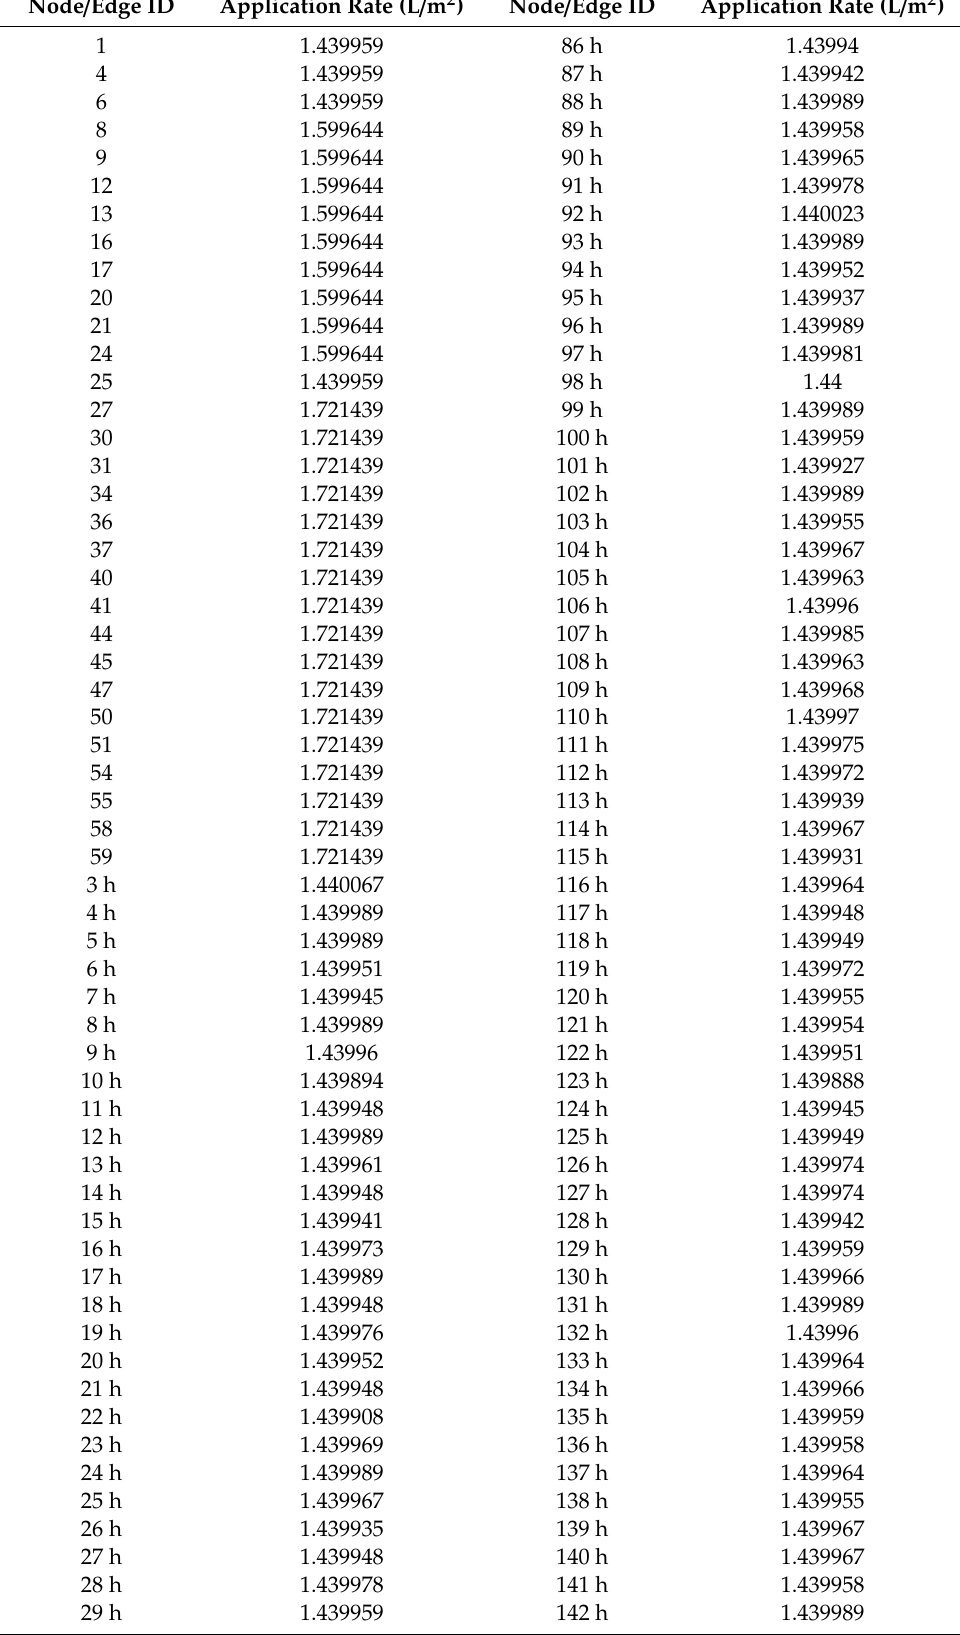
Table A2. List of application rates for operation